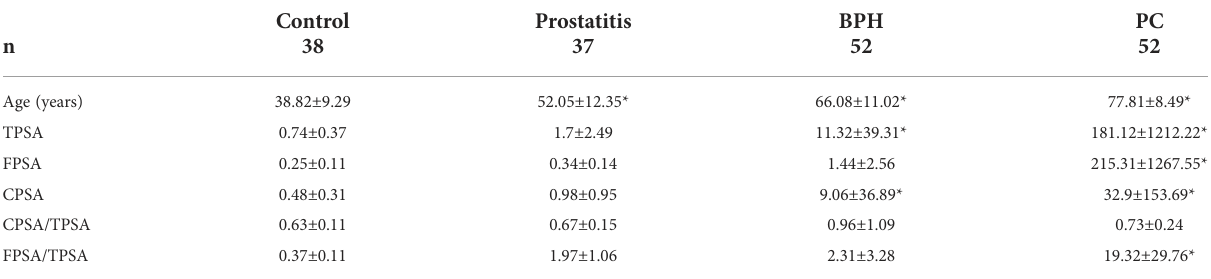
TABLE 2 Comparison of PSA levels in the validation